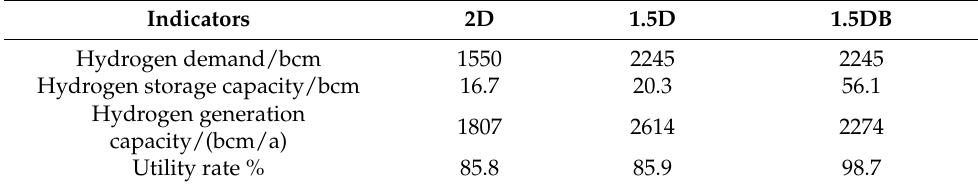
Figure 5. Hydrogen flows amongst regions in 2050: ( a ) 2-Degree scenario; ( b ) 1.5-Degree scenario; ( c ) 1.5-Degree scenario with blue hydrogen; ( d ) Comparison amongst scenarios. Table 8. Hydrogen system planning indicators in